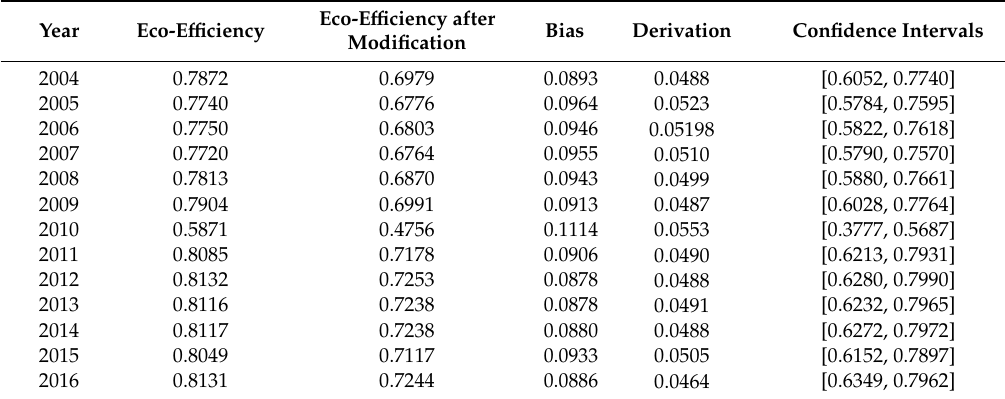
Table 2. Comparison between the eco-e ffi ciency values and their